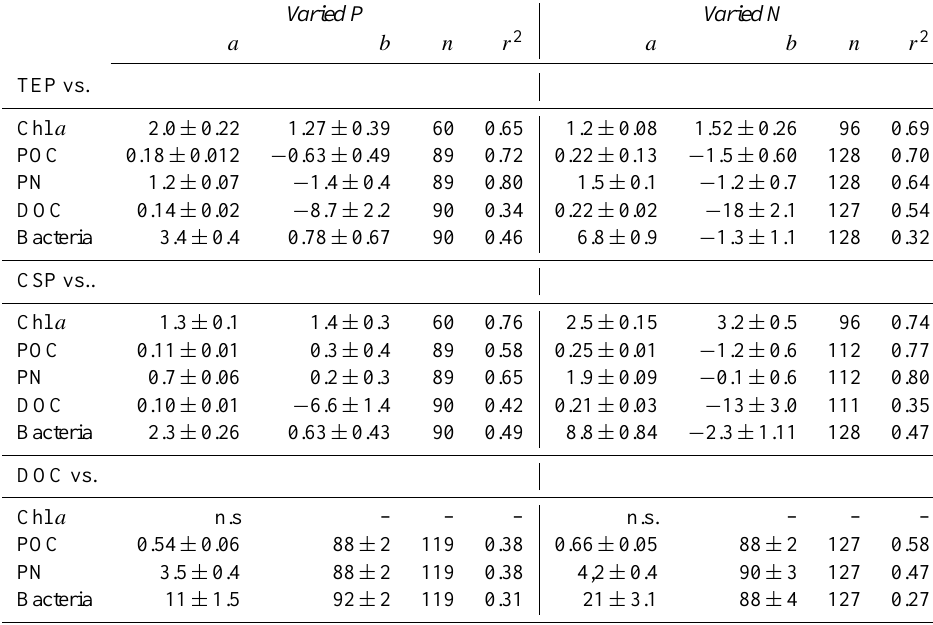
Table 3. Statistics for linear regression analysis of gel particle numerical abundance and DOC concentration against organic matter compo- nents during mesocosm experiments with different initial PO 3 − ( Varied P ; µmolL − 1 ) and NO − ( Varied N ; µmolL − 1 ) concentrations. Units 4 3 – TEP: × 10 7 L − 1 ; CSP: × 10 6 L − 1 ; POC: µmolL − 1 ; PN: µmolL − 1 ; Chl a : µgL − 1 ; DOCµmolL − 1 ; bacteria: × 10 6 mL − 1 ; a is the slope and b is the intercept; n.s. stands for “not significant”. See Fig. 7 for further information. Varied P Varied